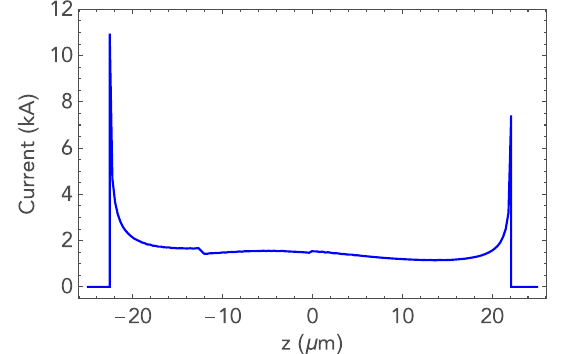
FIG. 12. Current profile calculated with the parametric equa- tions, Eqs. (16) and